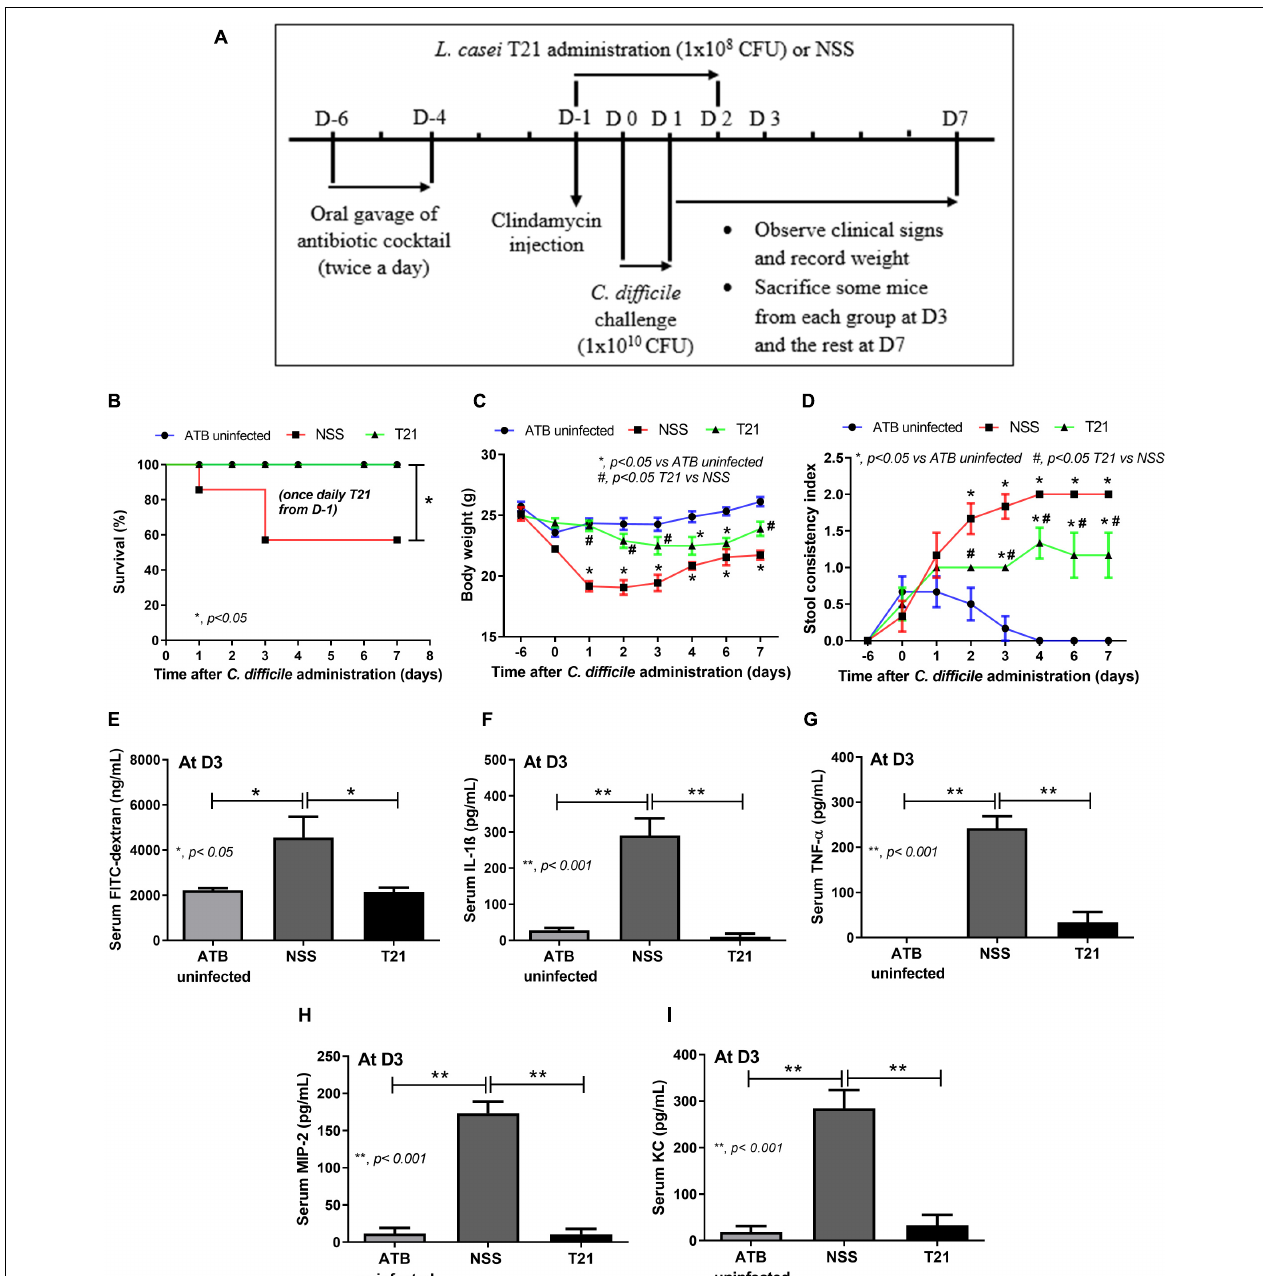
FIGURE 2 | Lacticaseibacillus casei T21 effectively attenuated C. difficile -induced severity in mice. Mice were randomly assigned to three groups: ATB uninfected group ( n = 18), NSS group ( n = 24), and T21 group ( n = 20) as described in the text and used in the experiment (A) . The reduction of severity was demonstrated by survival rate (B) ; body weight (n = number of mice/group or survivors) (C) ; stool consistency index (n = number of mice/group or survivors) (D) ; gut leakage by serum FITC-dextran assay monitored at day 3 ( n = 8) (E) ; and levels of serum pro-inflammatory cytokines IL-1 β (F) , TNF- α (G) , MIP-2 (H) , and KC (I) at day 3 ( n = 8). * p < 0.05; ** p < 0.001; # p <